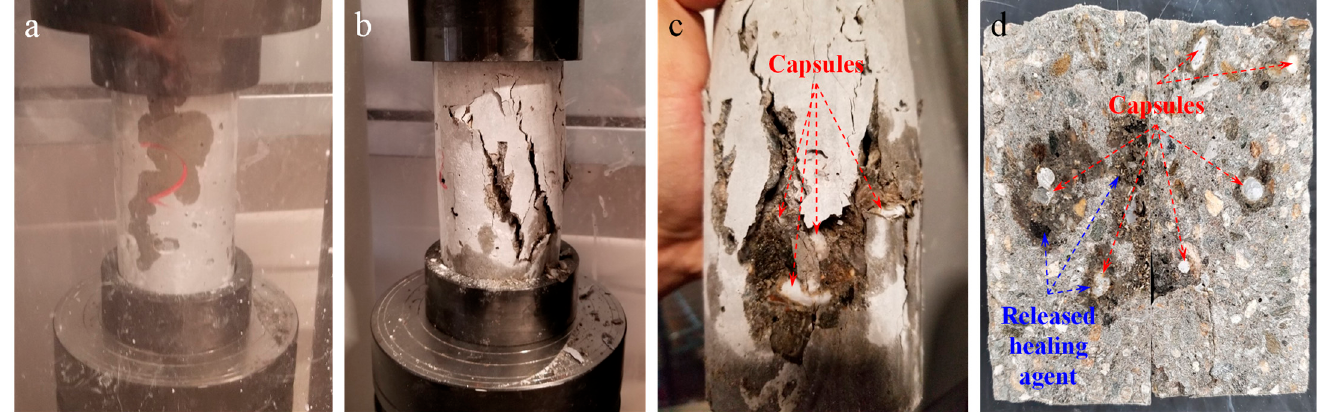
Figure 13. Exudation of self-healing agent: ( a ) and ( b ) during, and after ( c ) compression and ( d ) split tension test.